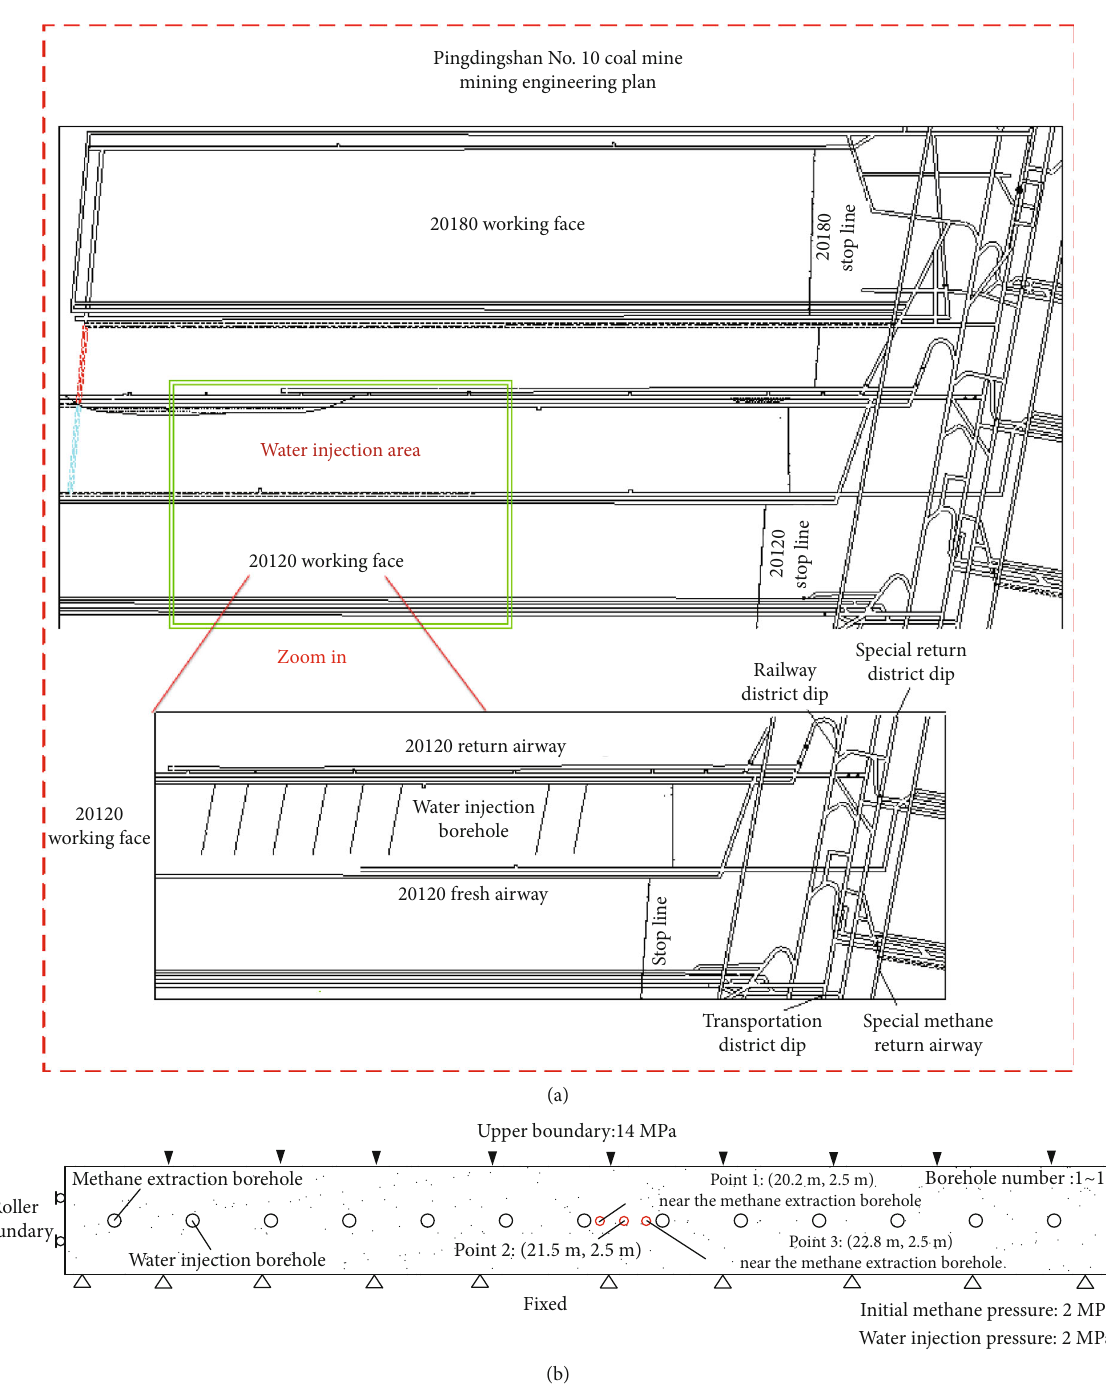
Figure 5: Mining plane graph and simulation model ((a) mining engineering plane; (b) numerical simulation